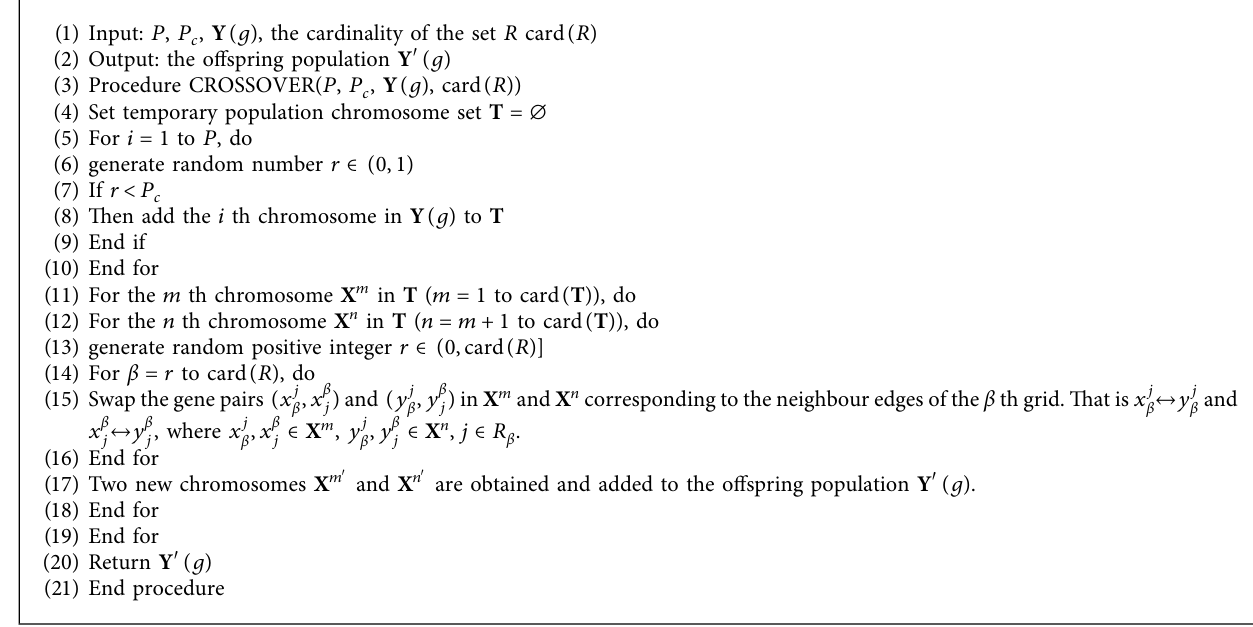
A LGORITHM 2 : Crossover algorithm in genetic algorithm.